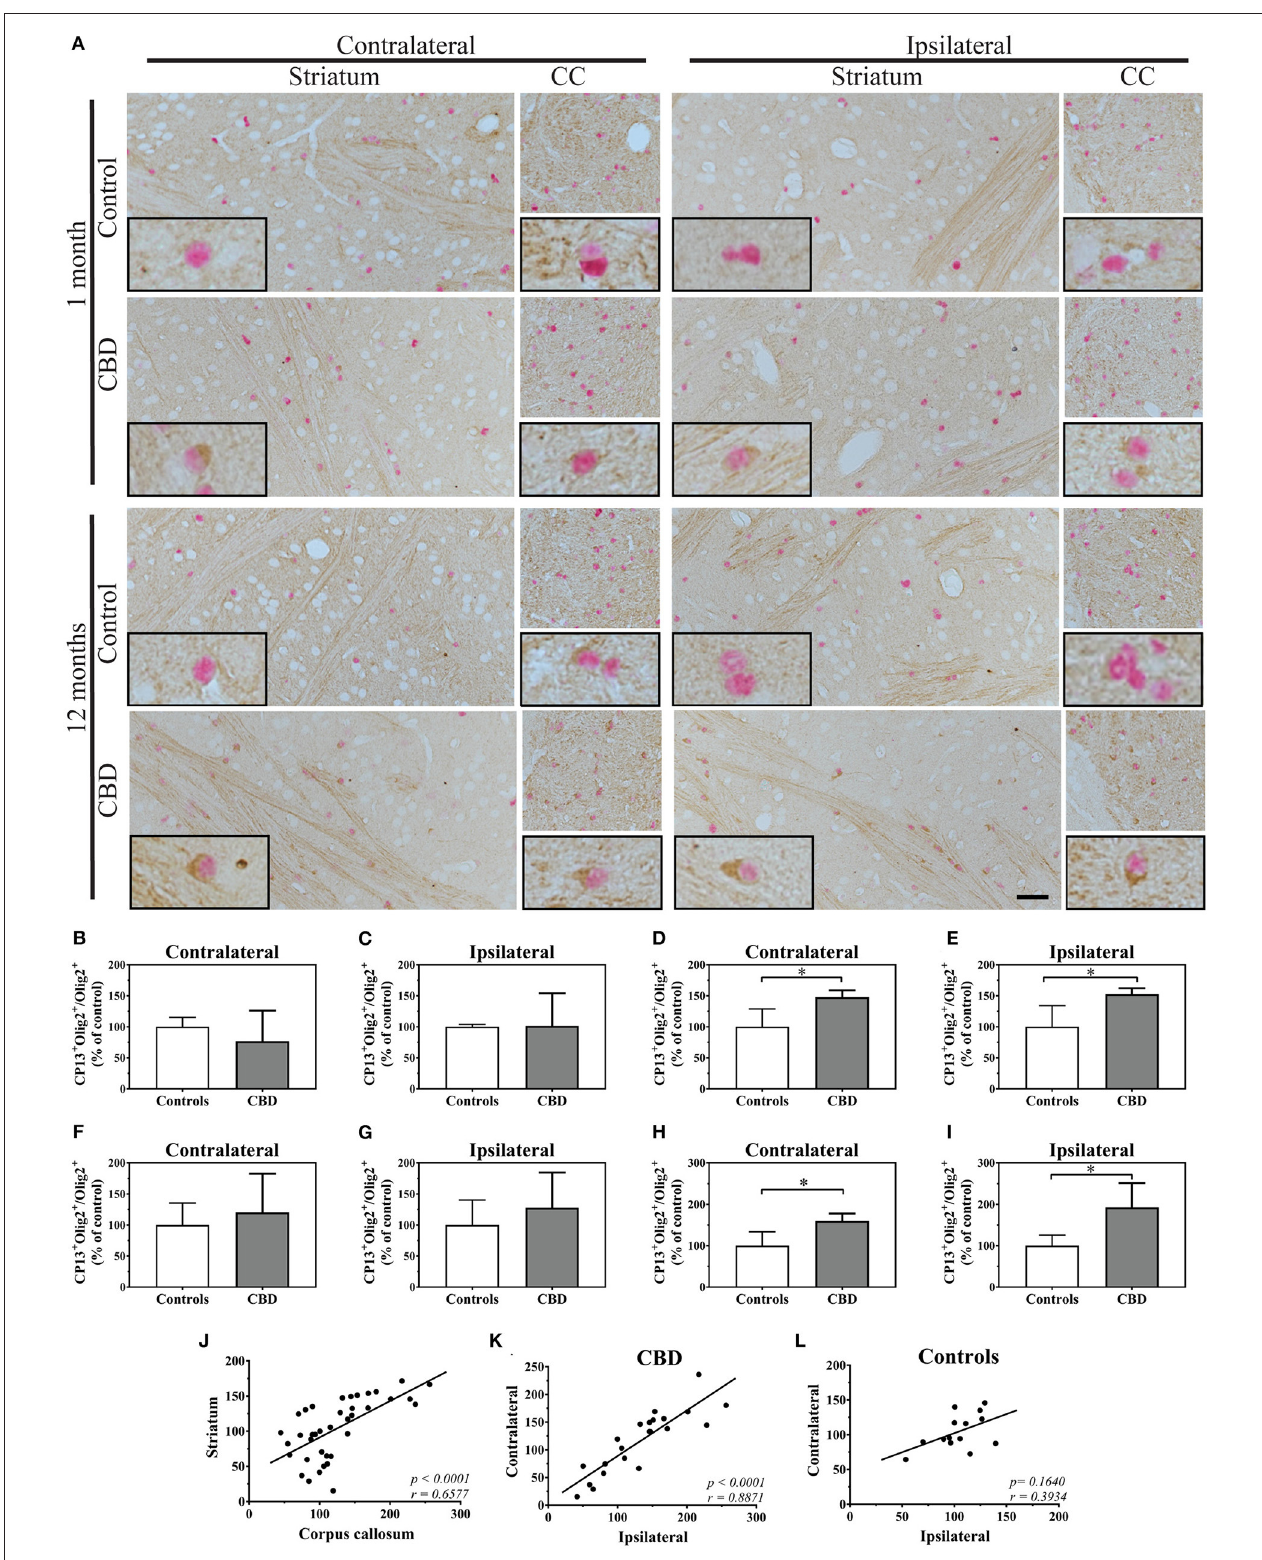
FIGURE 1 | The tau pathology transmission in oligodendrocytes. (A) The microphotography pictures of double immunohistochemistry staining of tau phosphorylated at Ser202 (CP13 antibody, brown chromogen) in oligodendrocytes (Olig2, nuclear marker, red/pink chromogen). The cell distribution in the contralateral (left panel)